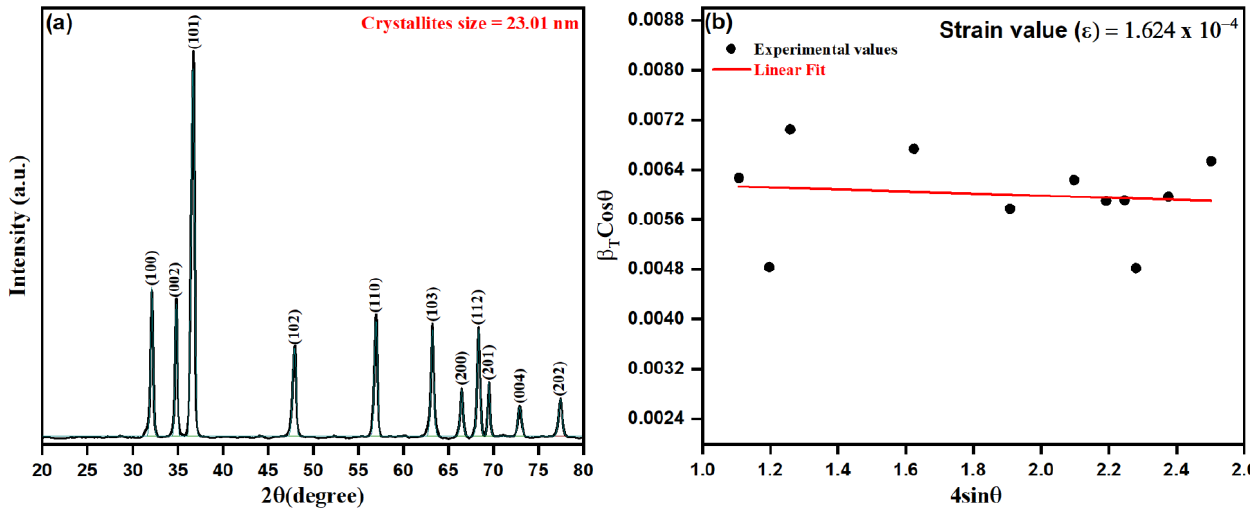
Figure 3. ( a ) XRD patterns of ZnO NPs, ( b ) Williamson–Hall plot for the ZnO NPs XRD pattern. Table 1. XRD data and crystallite size of ZnO